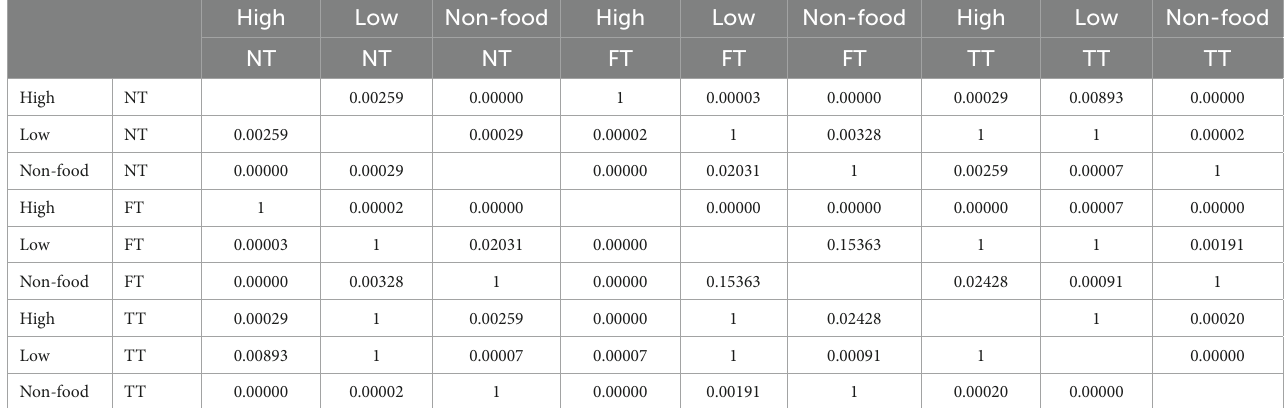
TABLE 3 RTs post-hoc results.